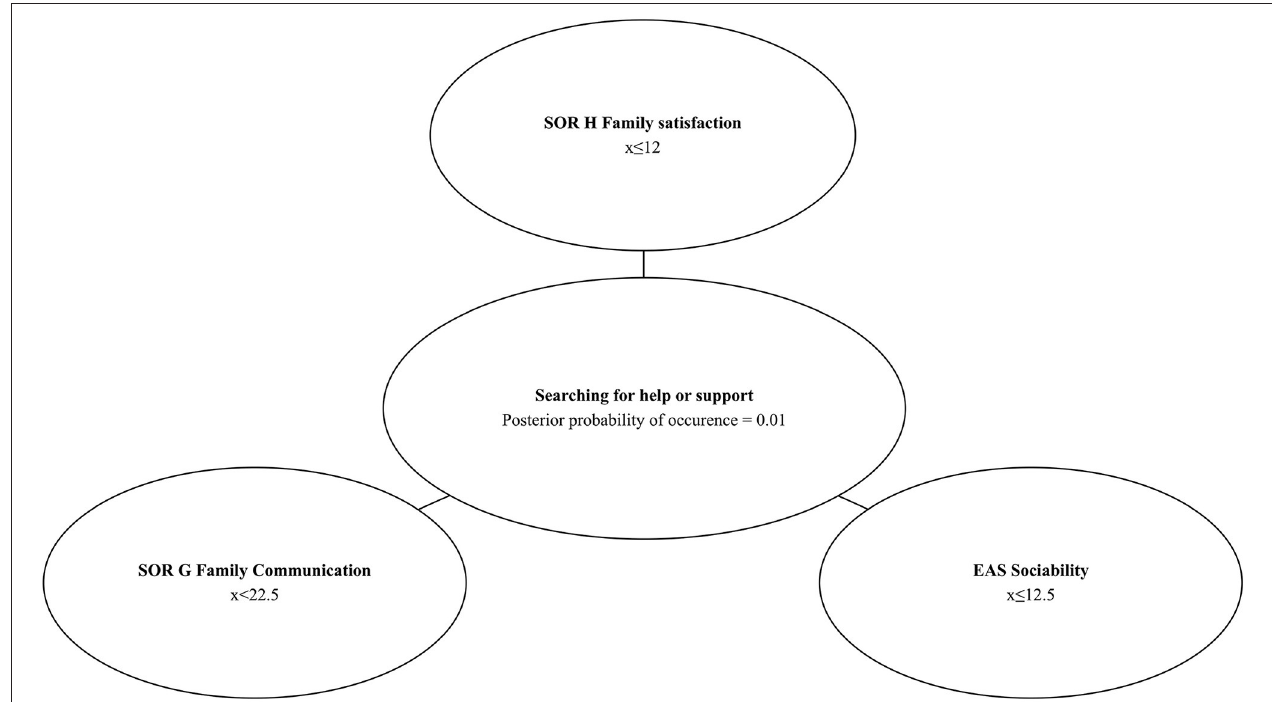
FIGURE 5 | Bayesian network–low posteriori conditional probability of searching for help or support.